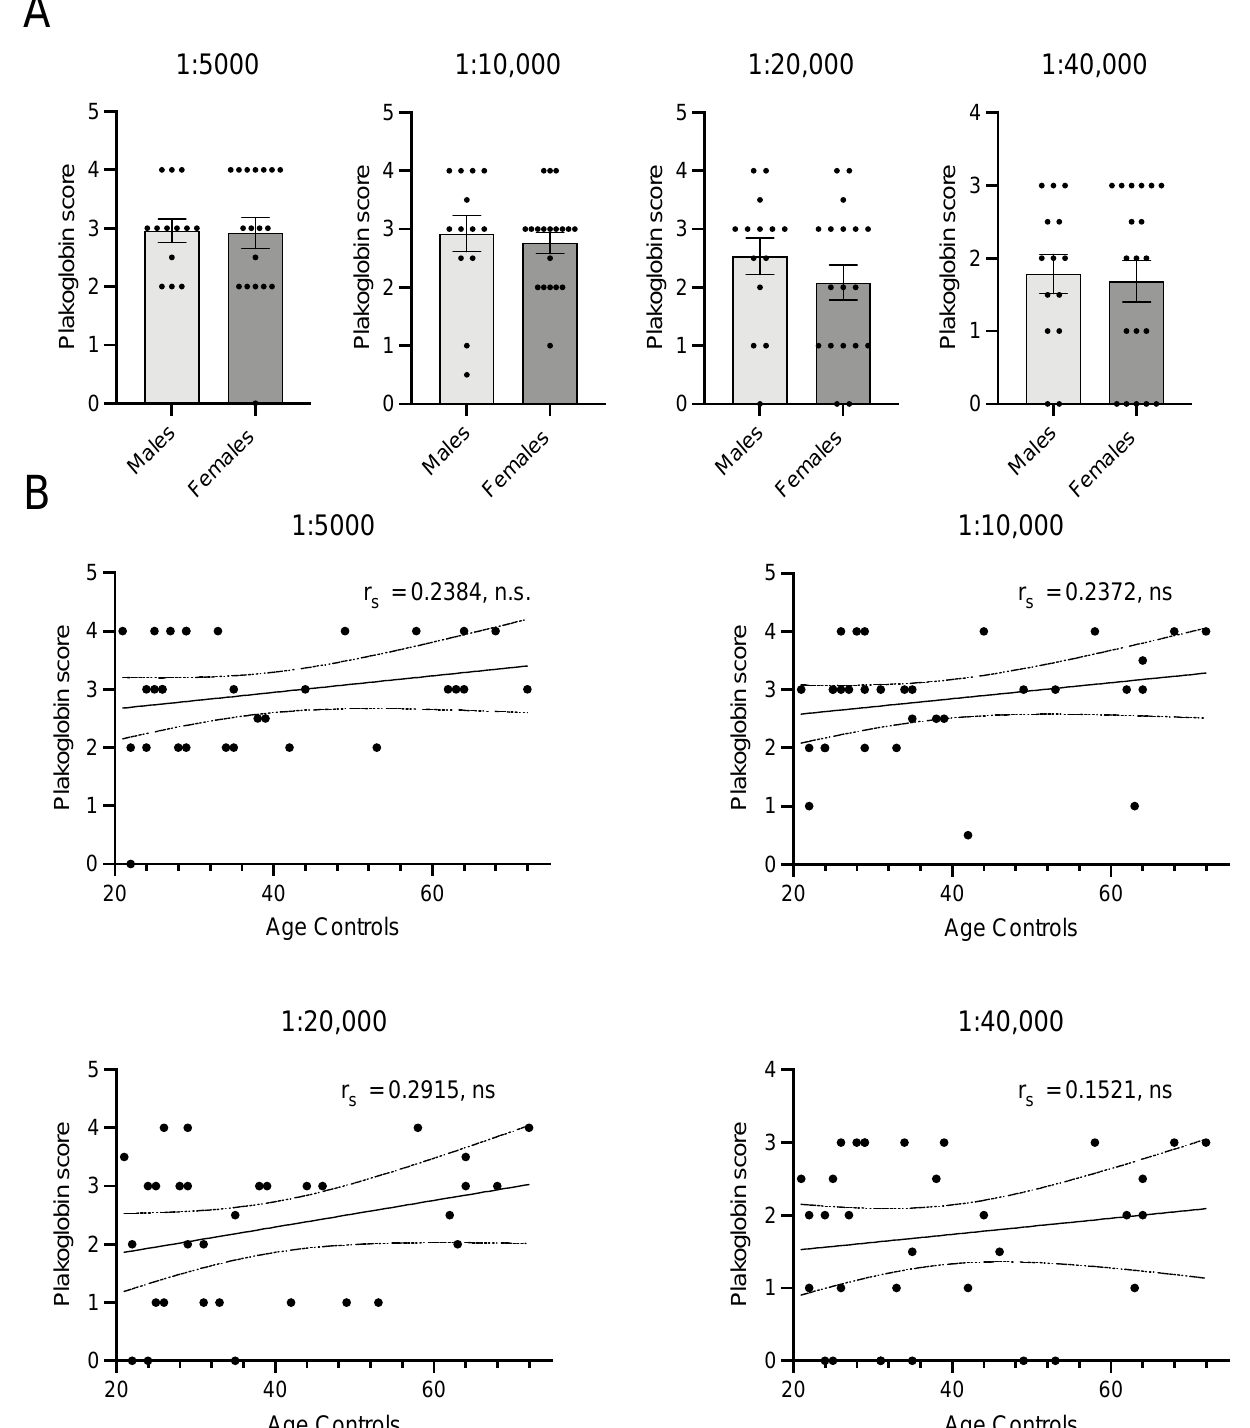
Figure 2. ( A ) Panel shows that there is no difference between membrane labelling score between males ( n = 14) and females ( n = 20) in any of the dilutions. ( B ) Depicts correlations between age and plakoglobin score. None of the dilutions show significant or biological relevant correlations with age. 1:5000 n = 31, 1:10,000 n = 32, 1:20,000 n = 32, 1:40,000 n = 33. r s ; Spearman’s rho, n.s.: not